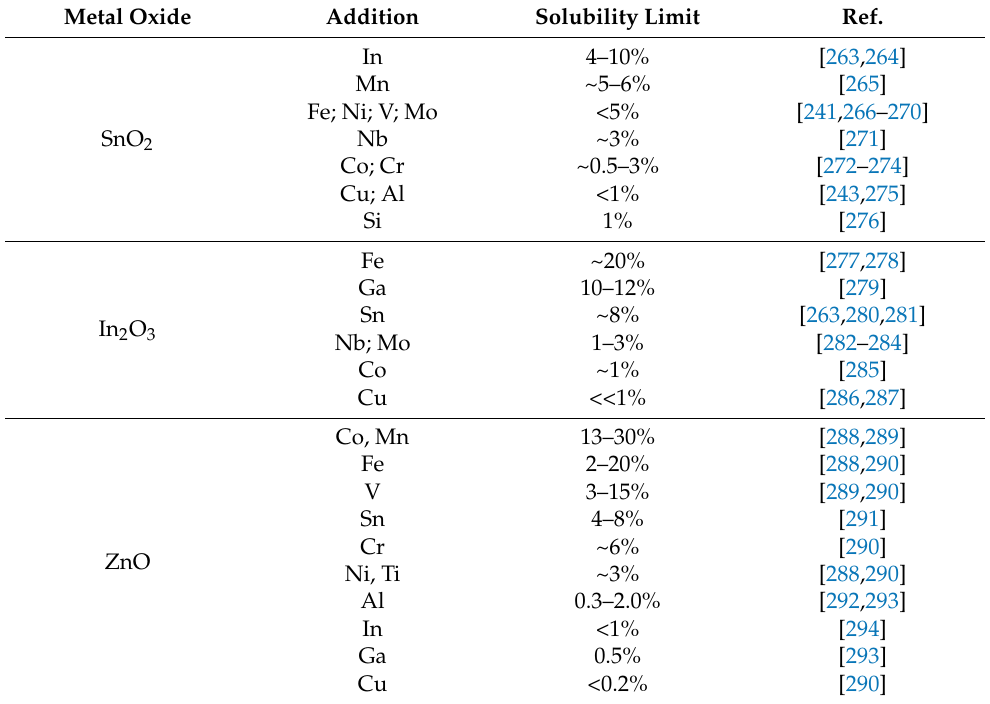
Table 6. Solubility limits for metals in metal oxides most promising for gas sensor applications. Metal Oxide